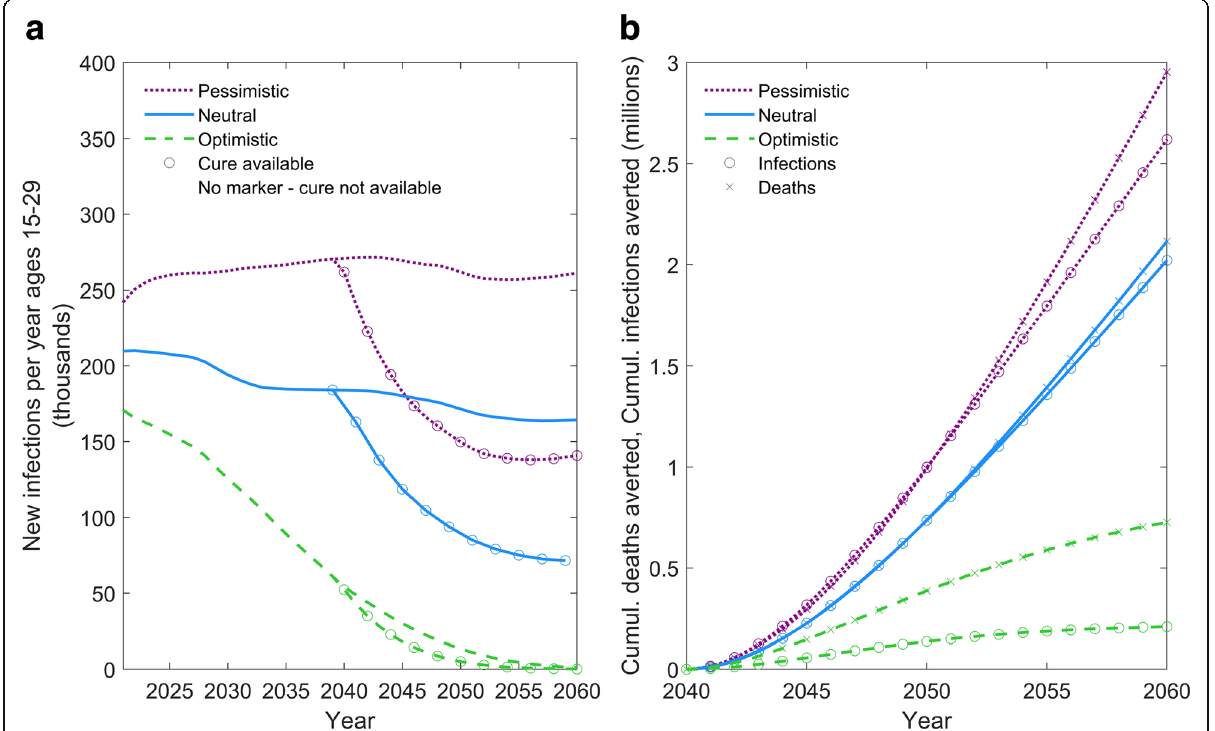
Fig. 1 The influence of epidemic context. The impact of the introduction of a curative intervention (under baseline assumptions) scaled-up in the context of either the pessimistic, neutral or optimistic forecasts for the HIV epidemic (Table 1) on ( a ) the number of new infections per year among 15 – 29years-old and ( b ) the cumulative infections and deaths